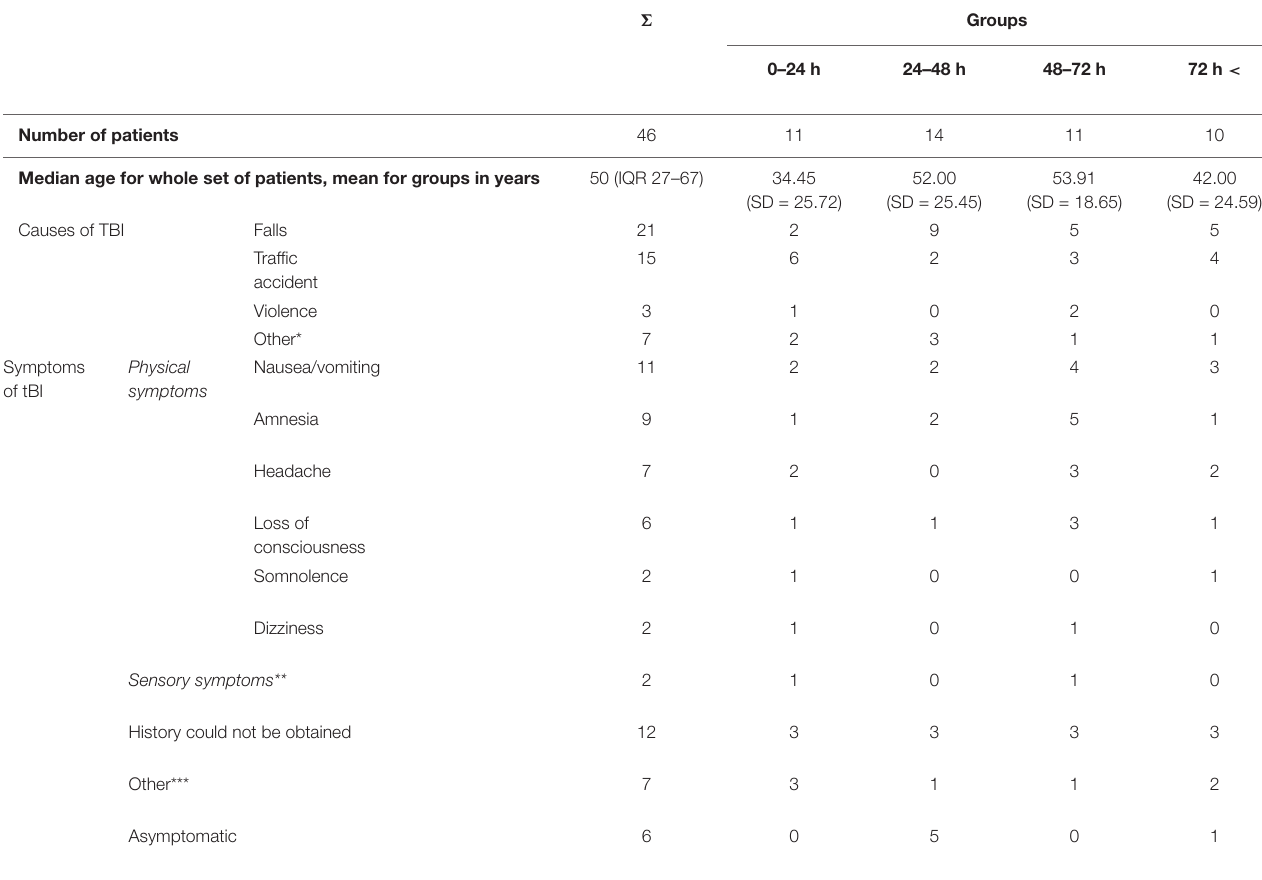
TABLE 1 | Age, causes, and symptoms of TBI according to admission